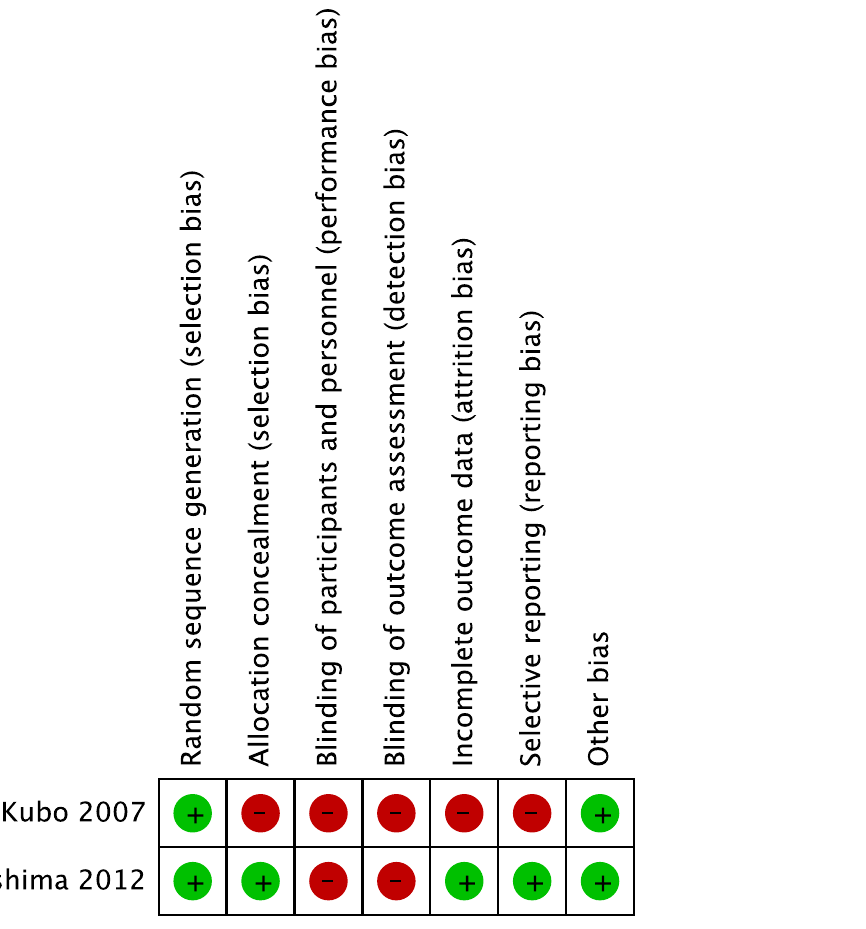
Fig. 2 Risk of bias summary for randomised clinical studies. Green and red circles indicate a low and high risk of bias, respectively